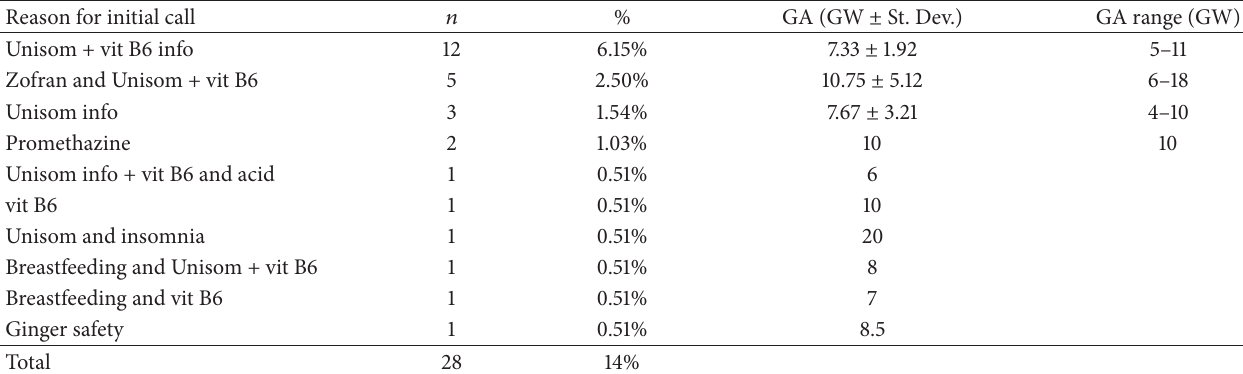
Table 4: Breakdown of the 68 women calling for NVP management info/and safety information on drugs used for controlling nausea or vomiting. Reason for initial call 𝑛 % GA (GW ± St. Dev.) GA range (GW) NVP info and Unisom + vit B6 26 NVP info and Zofran 16 NVP info and Unisom + vit B6, and acid NVP info and Unisom NVP info and vit B6 NVP info and Diclectin NVP info and nonmedical advice 2 NVP info and Zofran and Unisom + vit B6 and acid NVP info and Zofran and Unisom + vit B6 0.51 NVP info and Zofran and vit B6, and acid 1 0.51 — NVP info, dimenhydrinate, meclizine, and acid 1 0.51 Total 68 35%